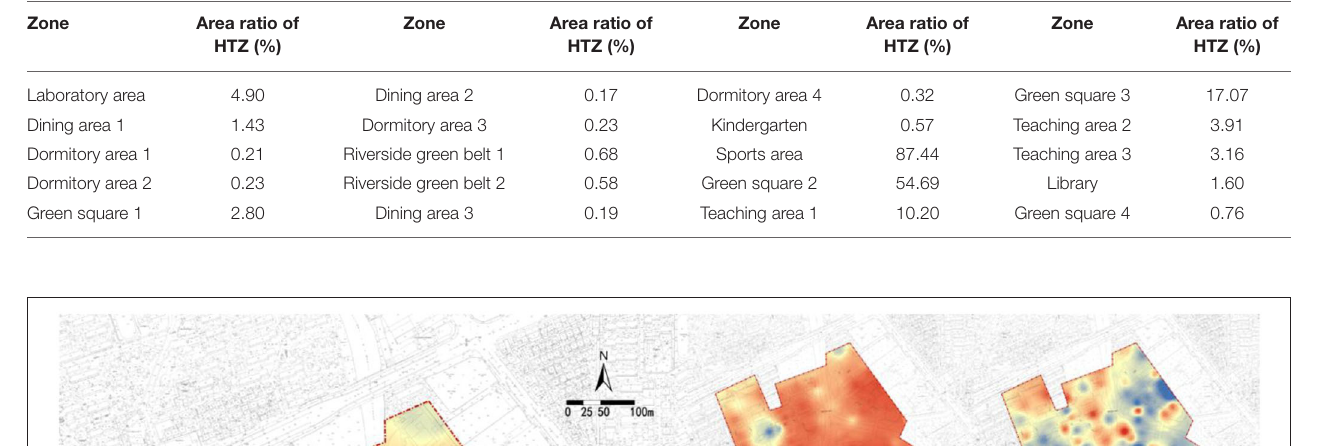
TABLE 6 | Area ratio of High-temperature Zone (HTZ) in each zone.